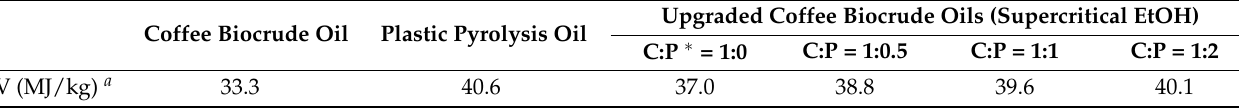
Table 5. Heating values of coffee biocrude oil, plastic pyrolysis oil, and upgraded coffee biocrude oils. Coffee Biocrude